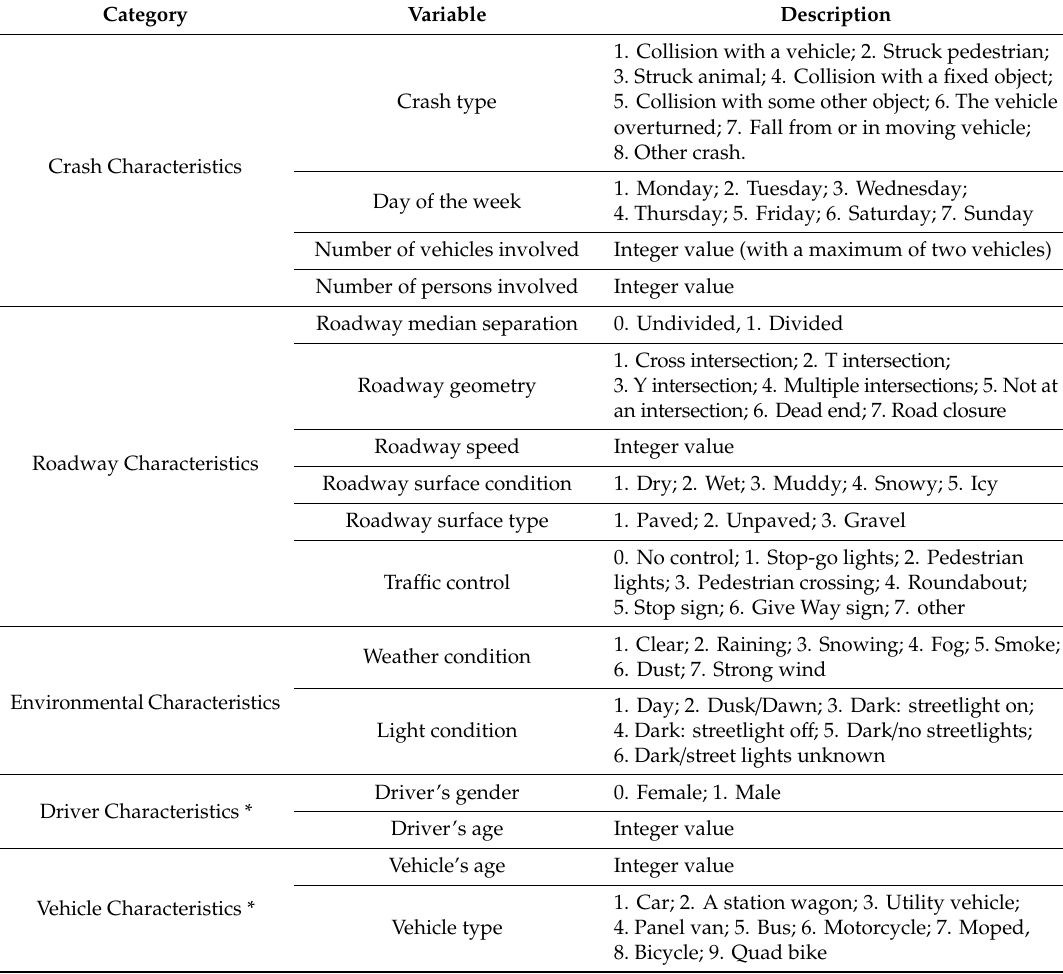
Table 1. Crash, driver, vehicle, and environmental